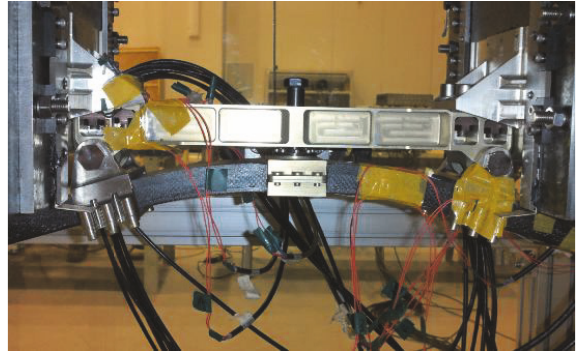
Figure 4: Setup of experimental modal analysis.